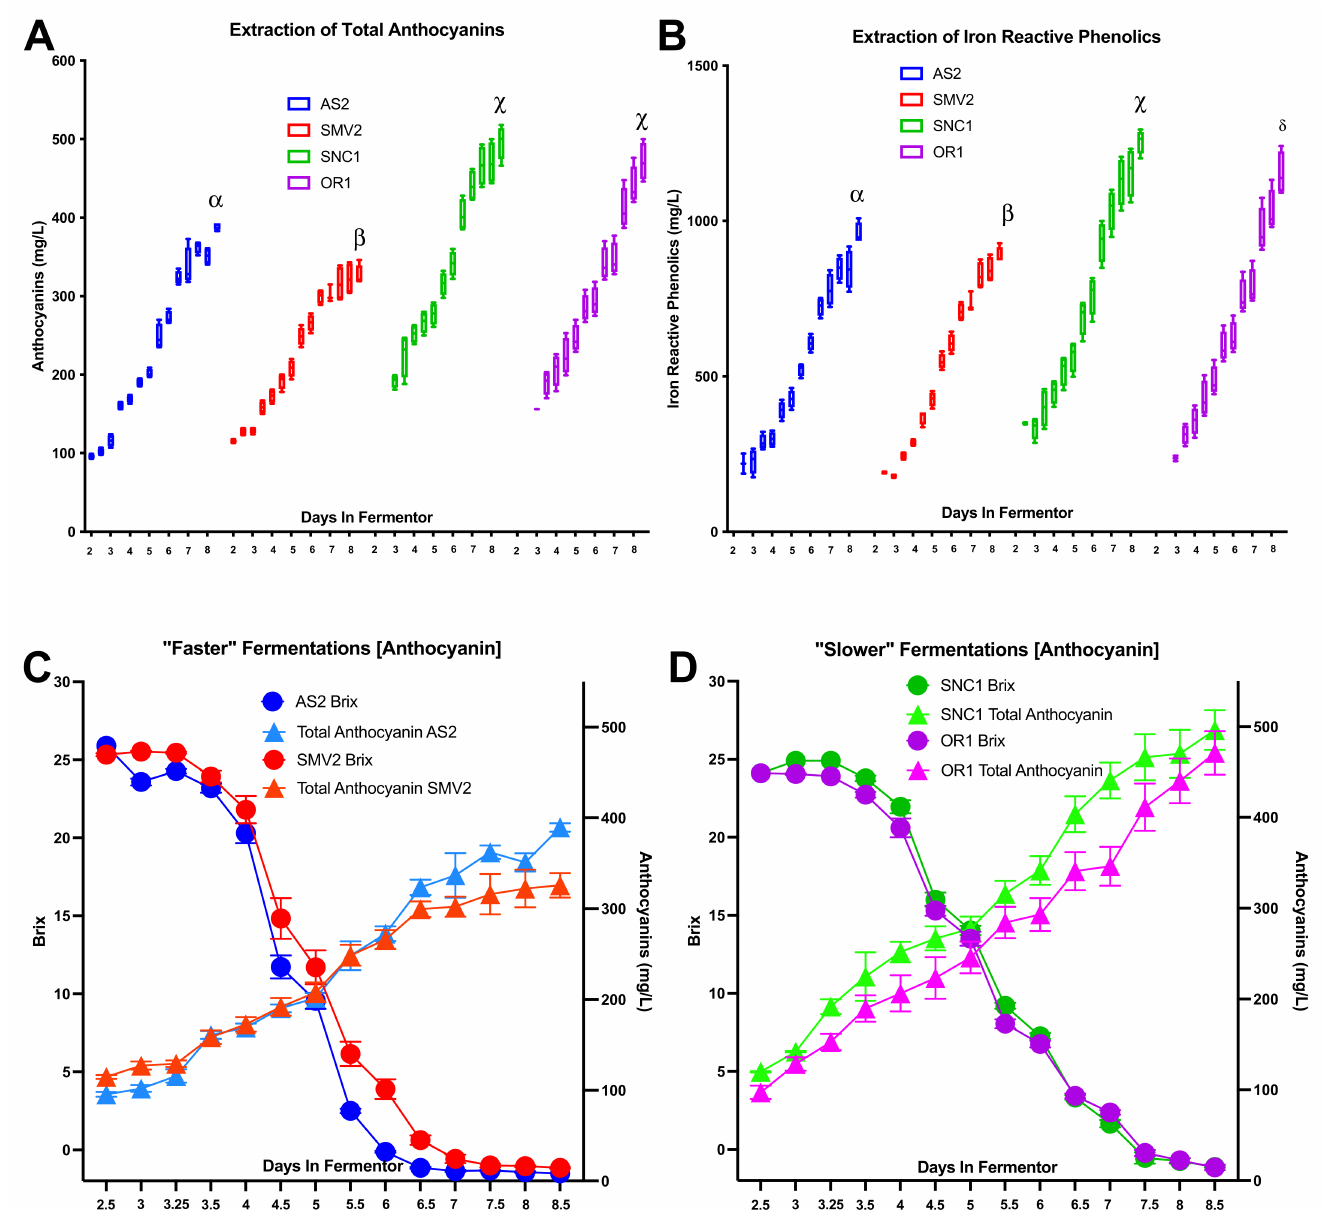
Figure 5. ( A ) Total anthocyanins over the course of fermentation, as measured by “Malvidin 3-glucoside equivalents”; Greek numerals denote significant differences in the values at the last time point as determined by Fisher’s LSD (least significant difference). ( B ) Total iron reactive phenolics over the course of fermentation, as measured by “Catechin equivalents”; Greek numerals denote significant differences in the values at the last time point as determined by Fisher’s LSD. ( C , D ) Visualization of fermentation kinetics between “faster” ( C ) vs. “slower” ( D ) fermentations and extraction of total anthocyanins (similar trends observed for iron reactive phenolics, data not shown). The “faster” site displayed a lower rate of extraction than “slower” sites, as reported in Figure 1B. Despite the “slower” fermentation kinetics, the amount of anthocyanins is relatively high for these conditions than in the “faster”